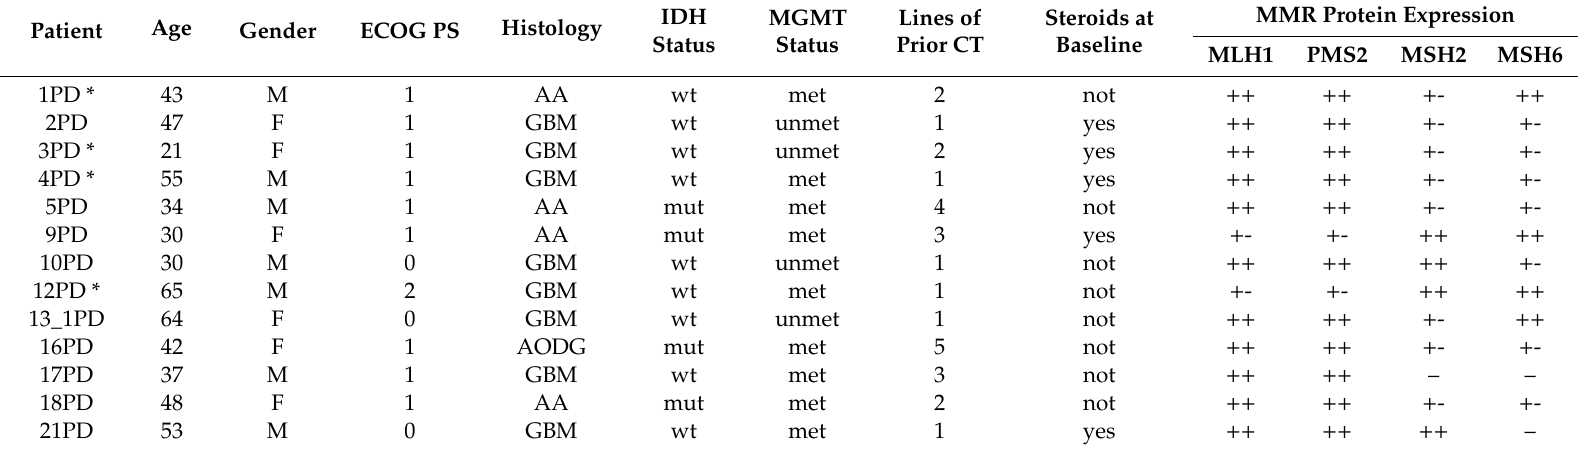
Table 1. Clinicopathological data of the 13 patients enrolled in the